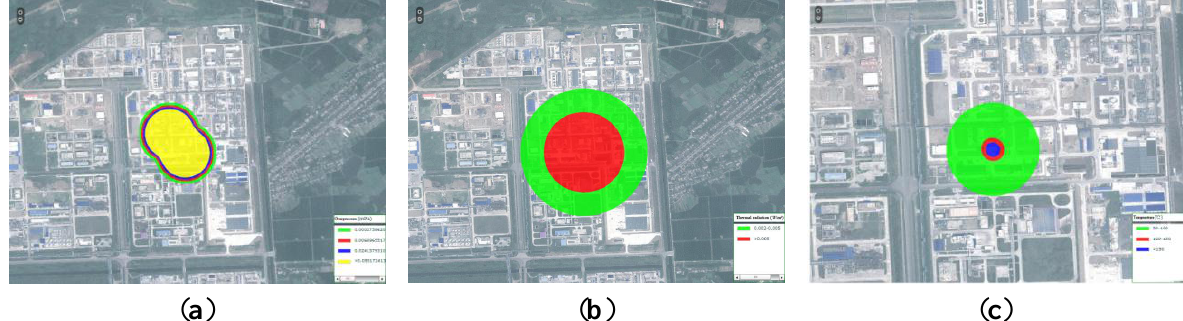
Figure 7. Simulation results of the explosion and conflagration. Images ( a ), ( b ), and ( c ) respectively present the overpressure, thermal radiation, and conflagration